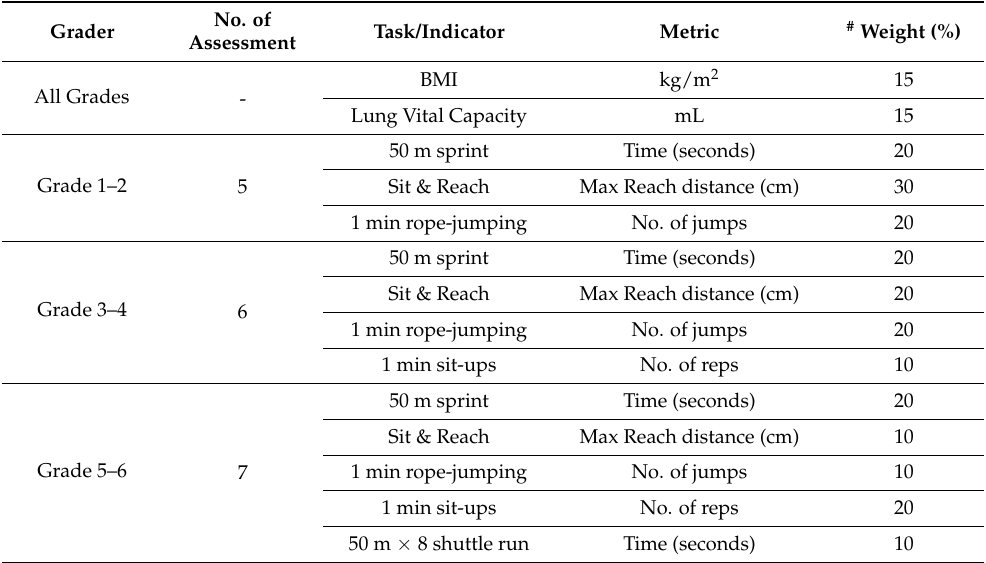
Table 1. Assessment tasks, indicators and weights of the National Student Physical Fitness Standard of China (version